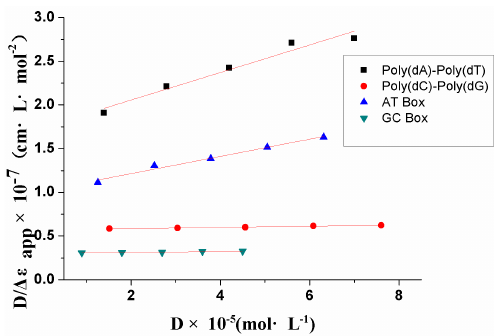
Figure 2 . D / Δε app vs. D plot of bis-naphthalimide derivative 4a (50 μ M) with different DNA duplexes in PBS buffer (50.0 mM, pH = 7.4).